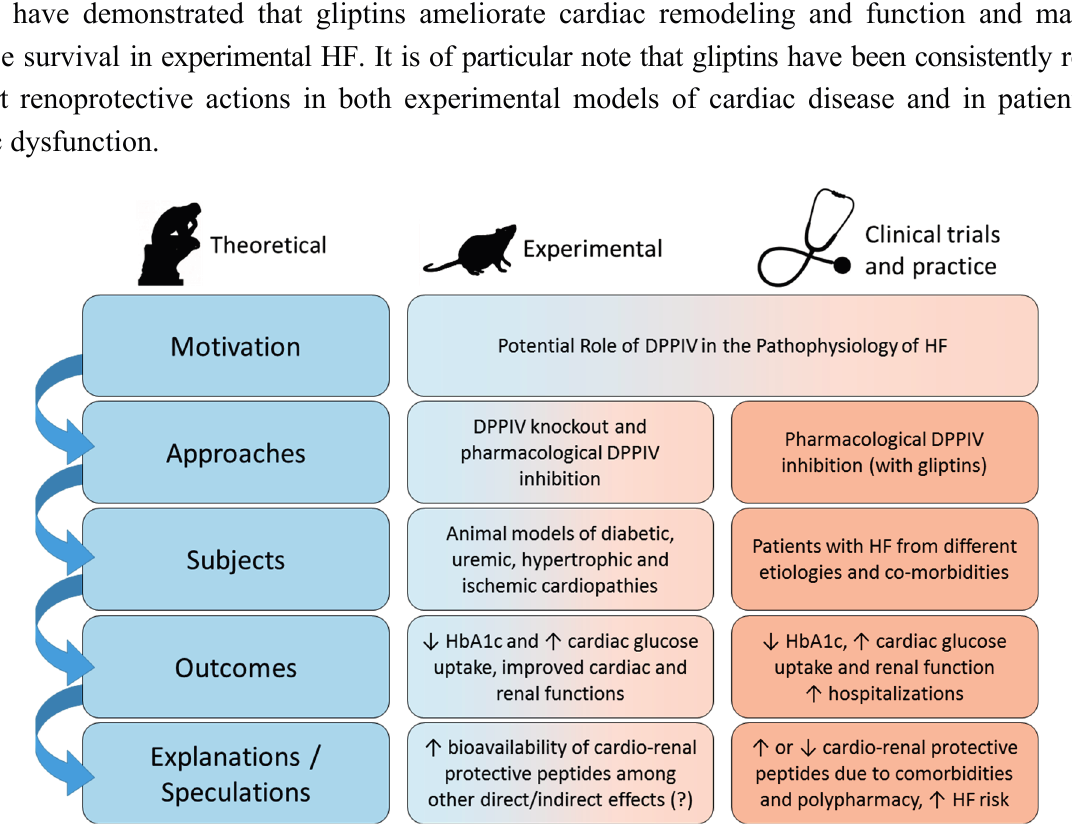
Figure 2. DPPIV as a therapeutic target in HF. Diagram summarizing the rationale and approaches used to test the hypothesis that DPPIV inhibition may exert cardio and renoprotective effects in experimental and clinical HF as well as the main outcomes obtained in experimental and clinical studies (see text for further